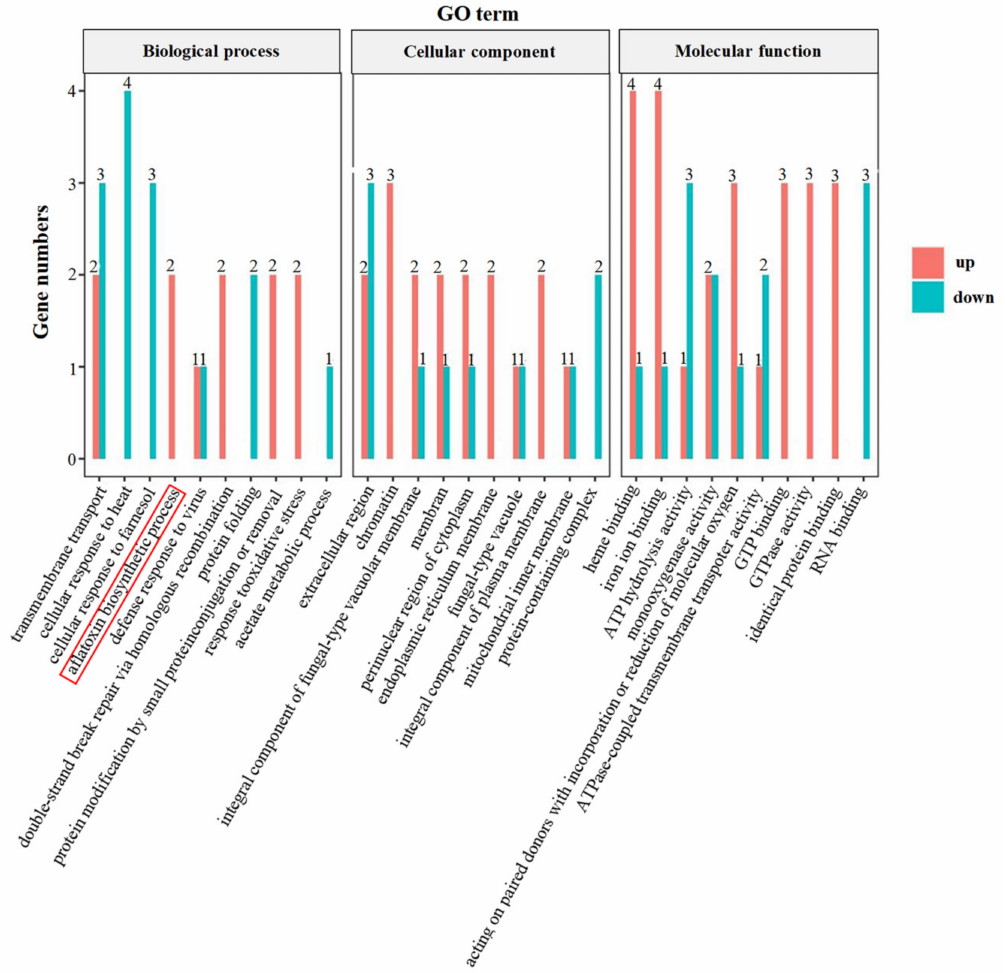
Figure 5. GO terms analysis of DEGs in A. flavus antagonized by B2. Red columns stand for up- regulated genes and blue for down-regulated genes. The GO term enriched for core DEGs was marked with a red box. Table 1. Related genes involved in the growth of A. flavus and aflatoxin synthesis.